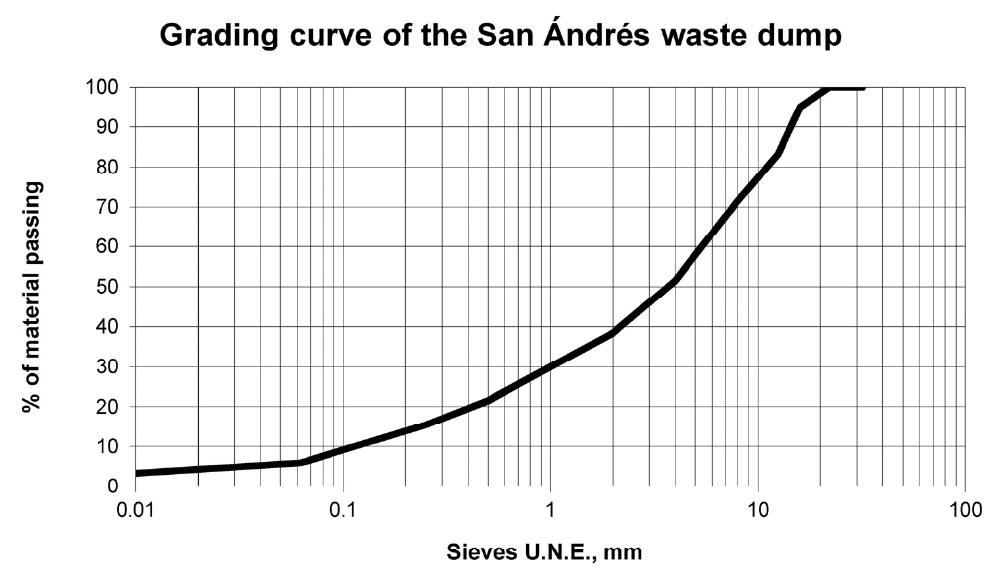
Figure 4. Grading curve of the San Andrés waste dump after the milling process.